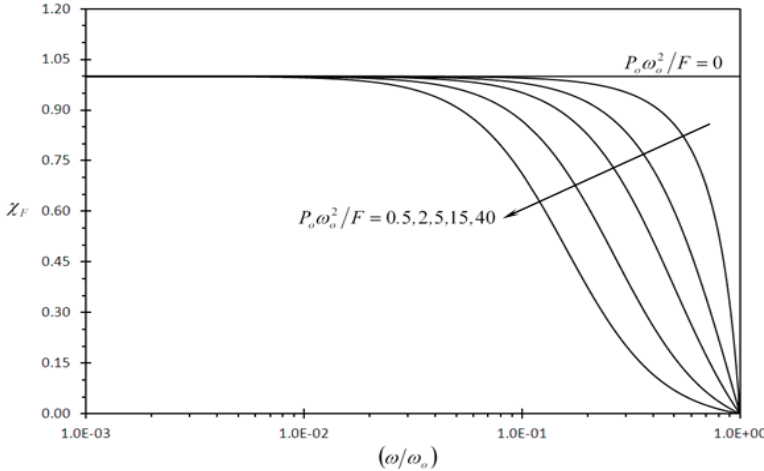
) and the o ω 2 / F } on the clearness o o ). F